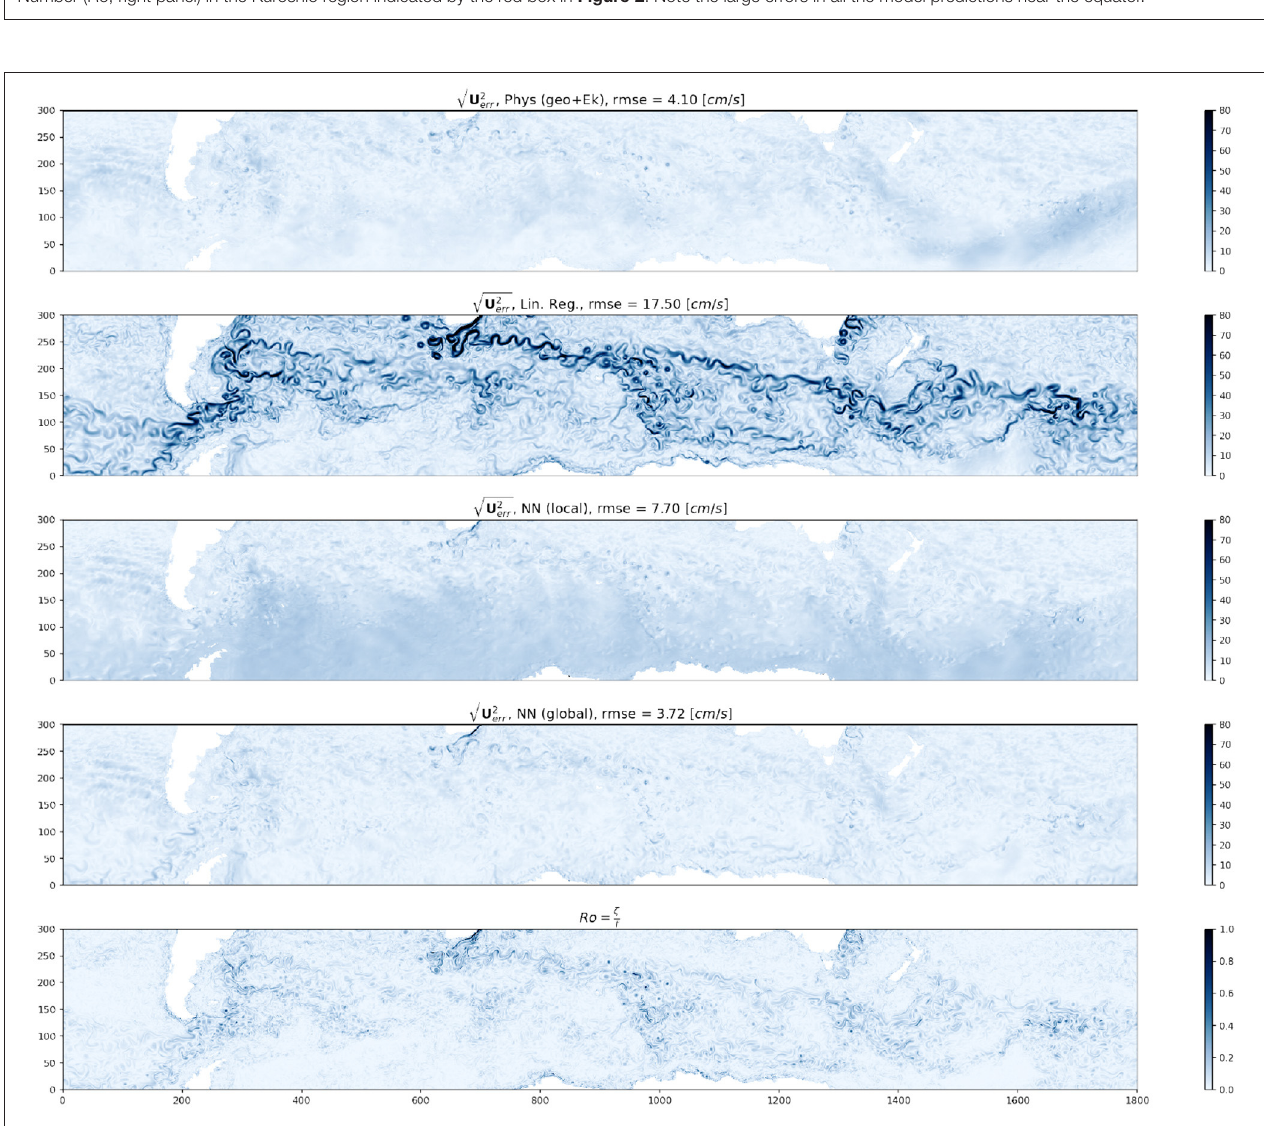
FIGURE 6 | Snapshot of model predicted root square errors for the physics based model (top) and the three different regression models—Linear regression (second panel), neural network, trained on this local domain (third panel) and neural network, trained on the globe (4th panel) compared side by side with the local Rossby Number (Ro, bottom panel) in the Southern Ocean/Antarctic circumpolar current region indicated by the yellow box in Figure 2 .